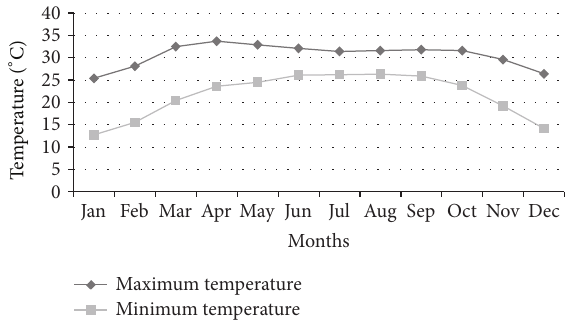
Figure 7: Maximum and minimum temperature ( ∘ C) trend in Dhaka